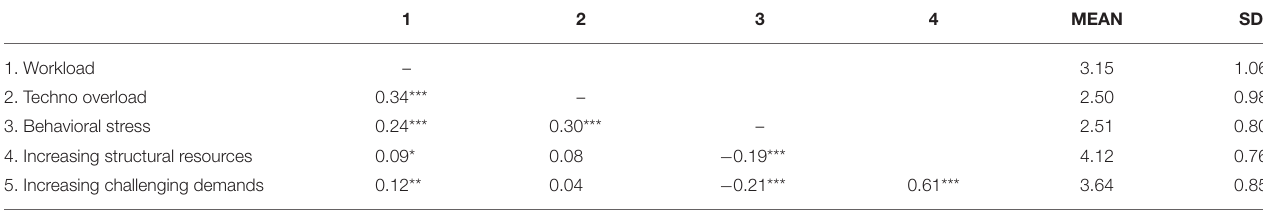
TABLE 1 | Correlations between manifest variables of the study, means, and standard deviations.